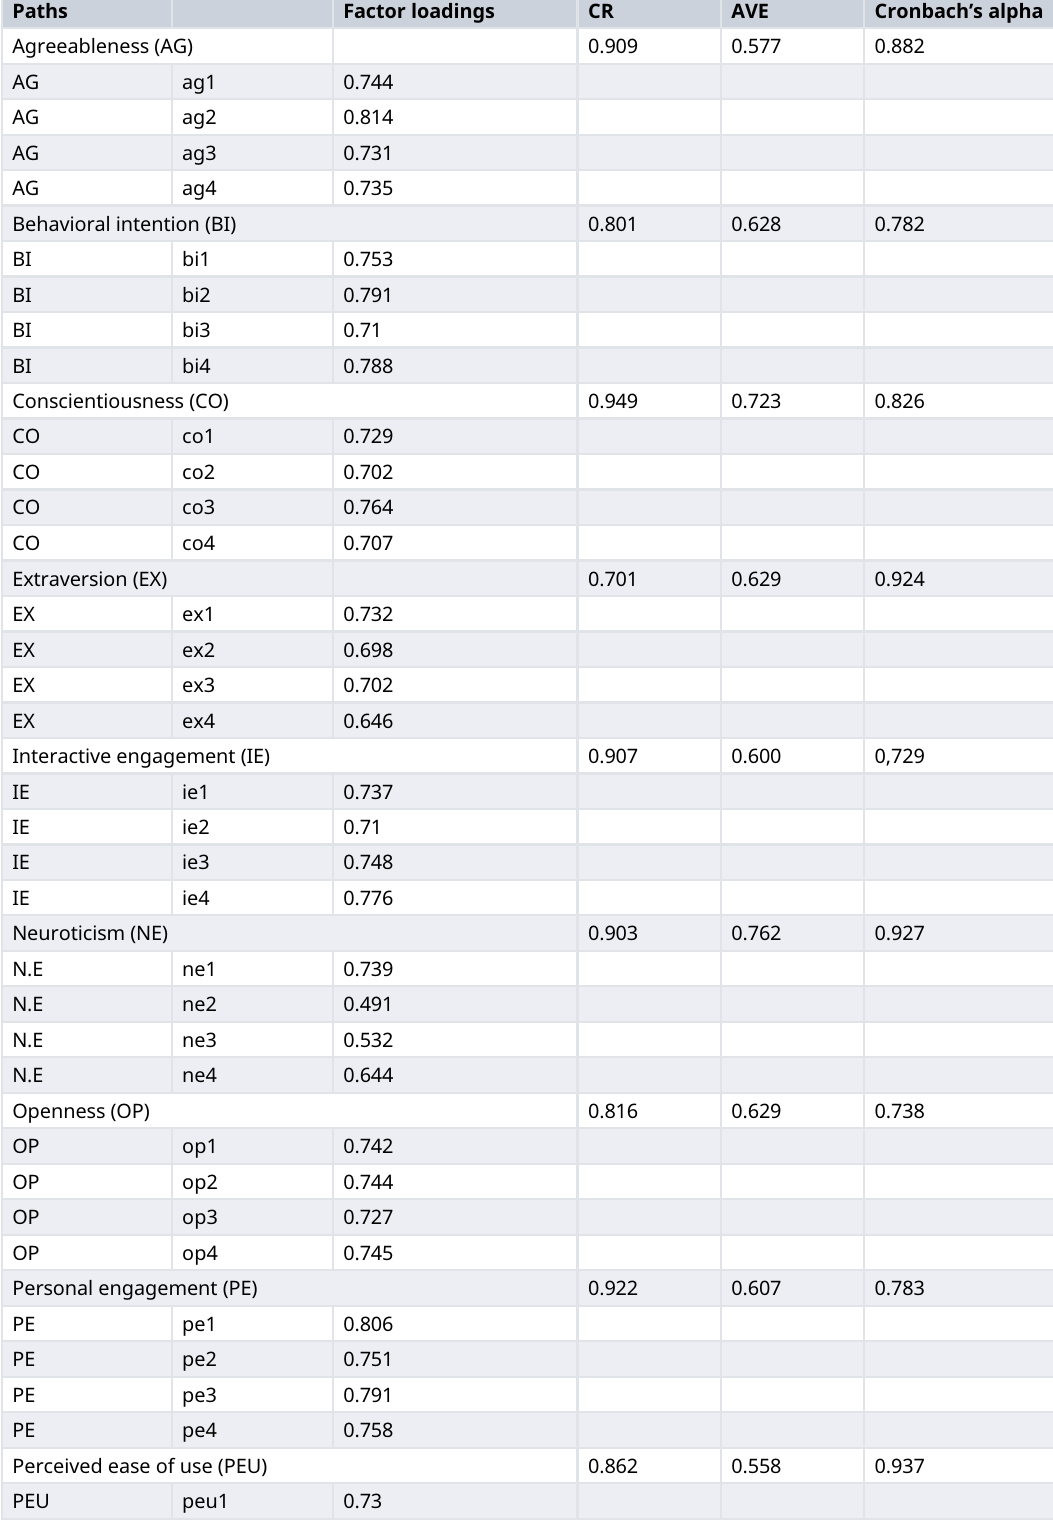
Table 3. Confirmatory factor analysis (CFA) and model